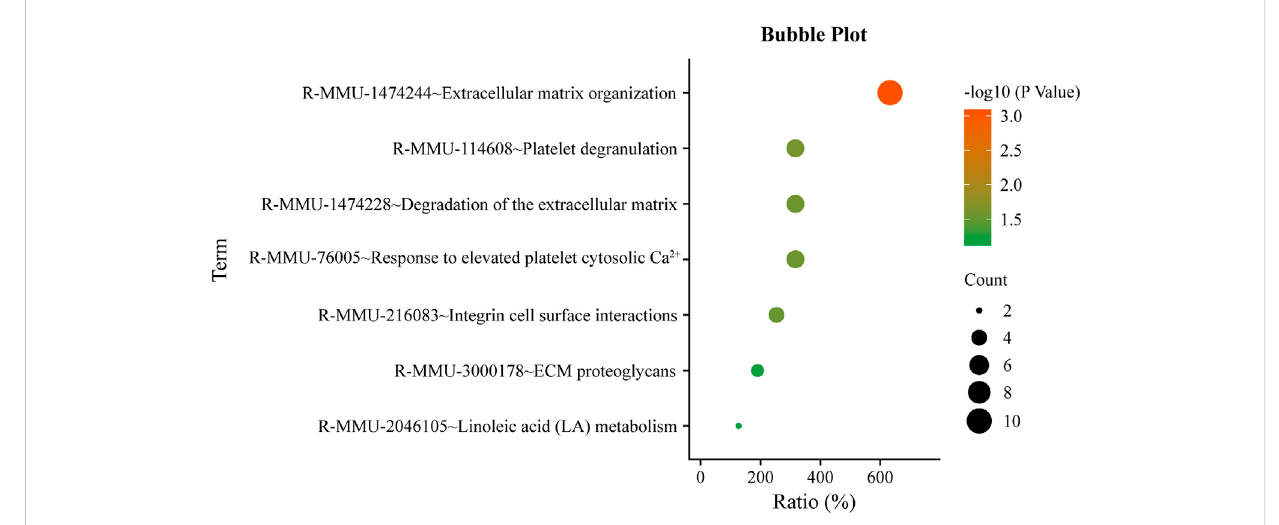
FIGURE 4 The Reactome pathways of 184 candidate genes screened out with